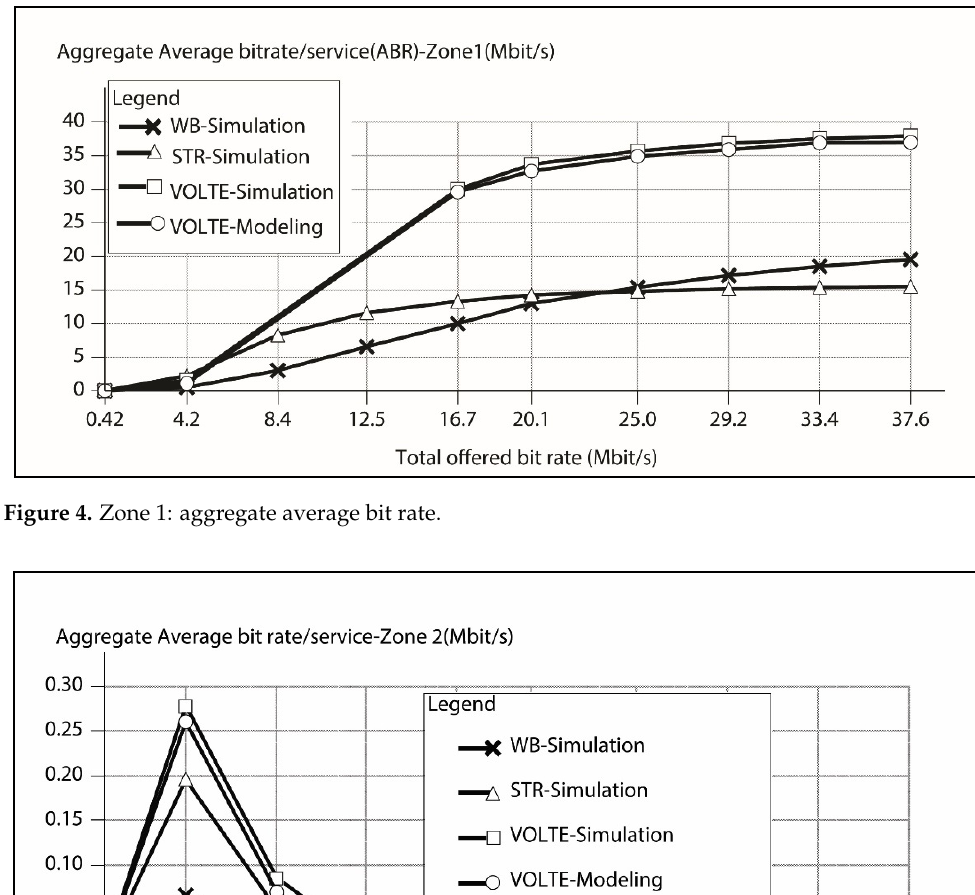
Figure 4. Zone 1: aggregate average bit rate.